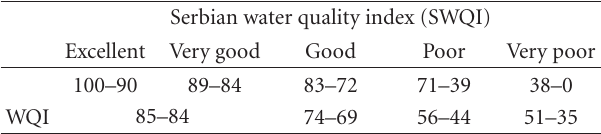
Table 1: Classification of the surface water by the SWQI method.